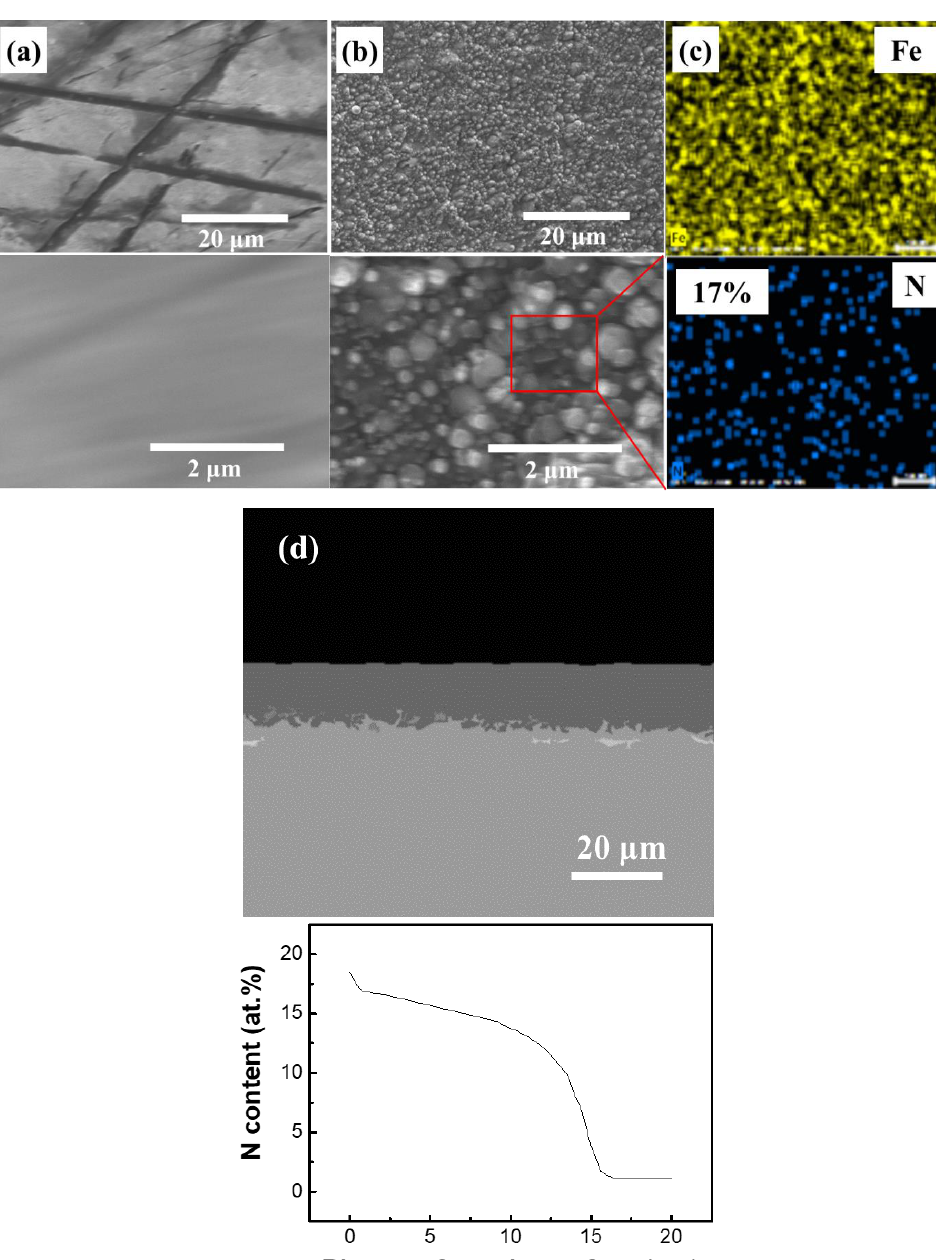
Figure 2. OM surface morphologies and cross-sectional microstructures of the samples ( a ) S1, ( b ) S2, and ( c ) S3.